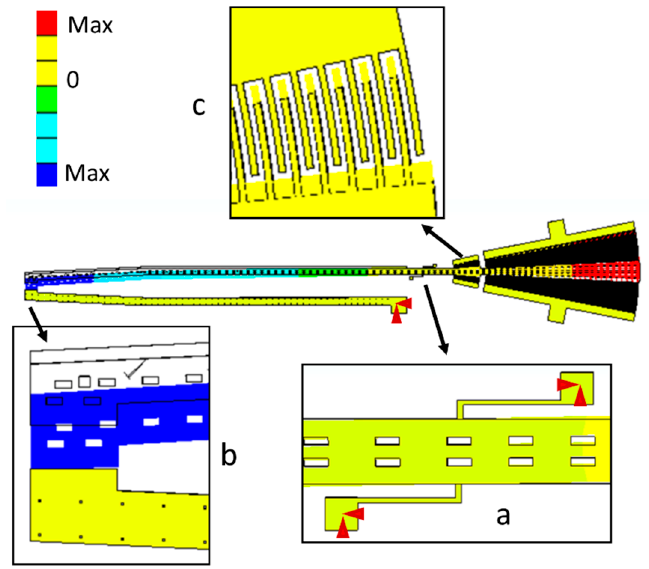
Figure 13. Displacements of the FEM model of the microgripper using solid187 elements of ANSYS software.